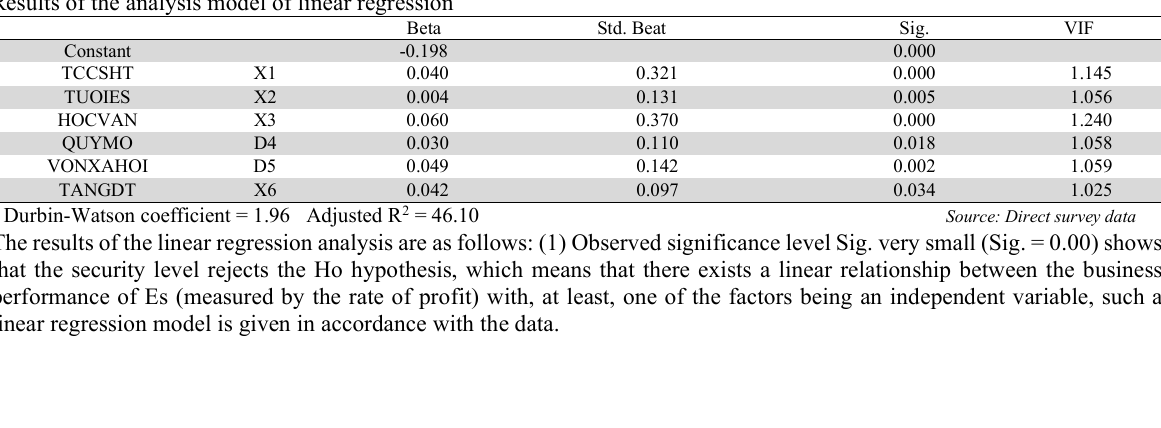
Results of the analysis model of linear regression